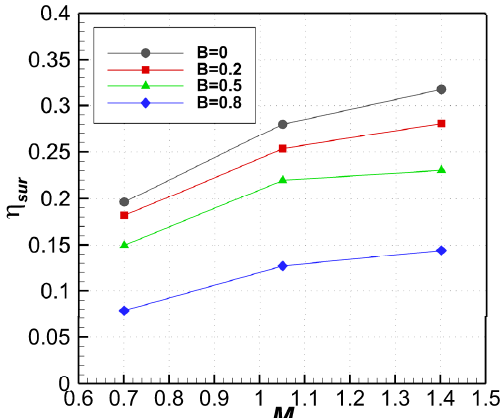
Figure 15. Surface averaged film effectiveness at different blockage ratios.